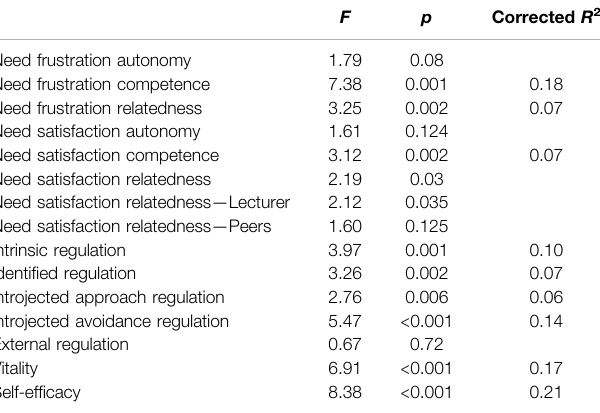
TABLE3| Resultsofthefullmodels(linearregression)withthedependentvariable (left column) and gender, age, rMEQ score, and personality as predictor variables of the basic psychological need satisfaction and frustration, motivational regulation, vitality, and self-ef fi cacy. The corrected R-squared is only given for the models with a p < 0.01.